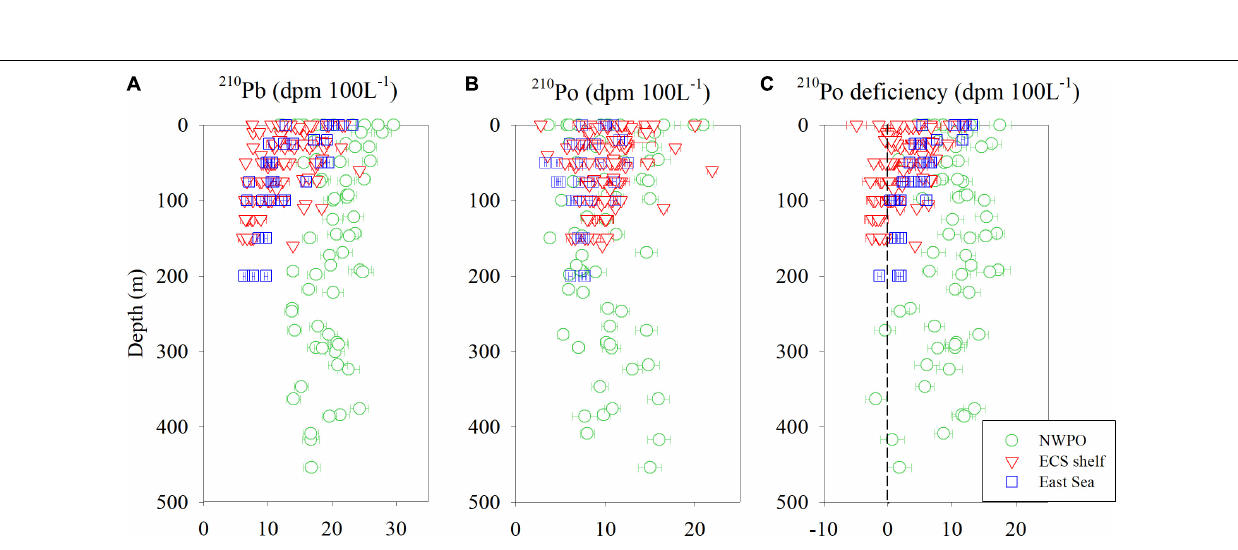
FIGURE 2 | Vertical distributions of 210 Pb (A) , 210 Po (B) , and 210 Po deficiency ( C ; 210 Pb- 210 Po) in the northwestern Pacific Ocean (NWPO; Tsunogai and Nozaki, 1971; Nozaki and Tsunogai, 1976; Nozaki et al., 1990a), the East China Sea (ECS) shelf water (Lee et al., 1996; Hong et al., 1999; Su et al., 2017; this study), and the East Sea (Kim and Kim, 2012; this